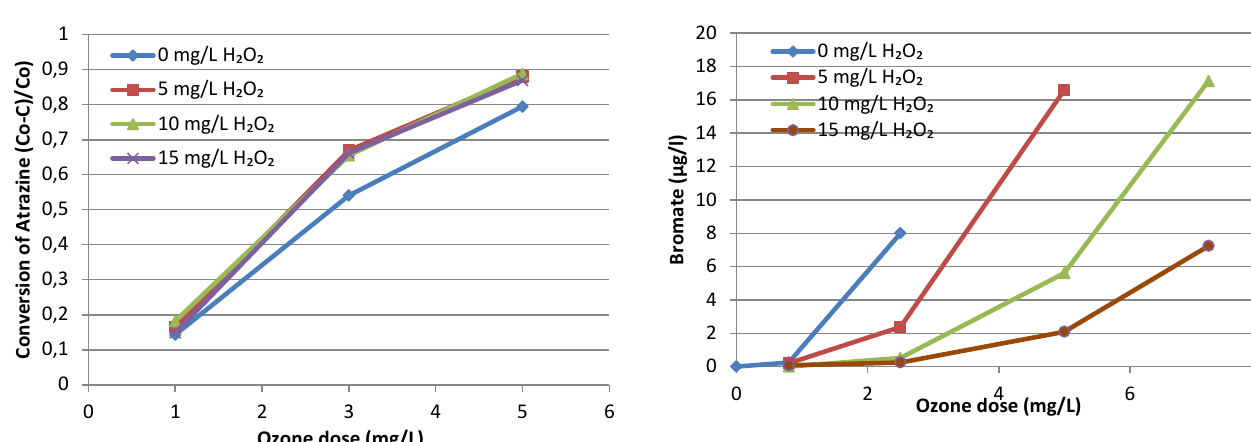
Figure 3. Conversion of atrazine at different settings of the perox- one process (Br − 124µgL − 1 , HCO − CL − 1 , water temperature 11.9 ◦ C).